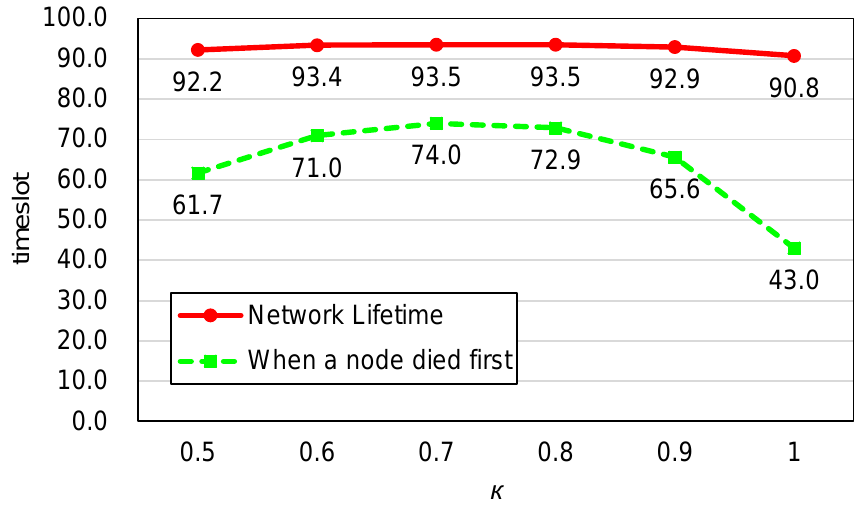
Figure 8. Average network lifetime against κ in Equation